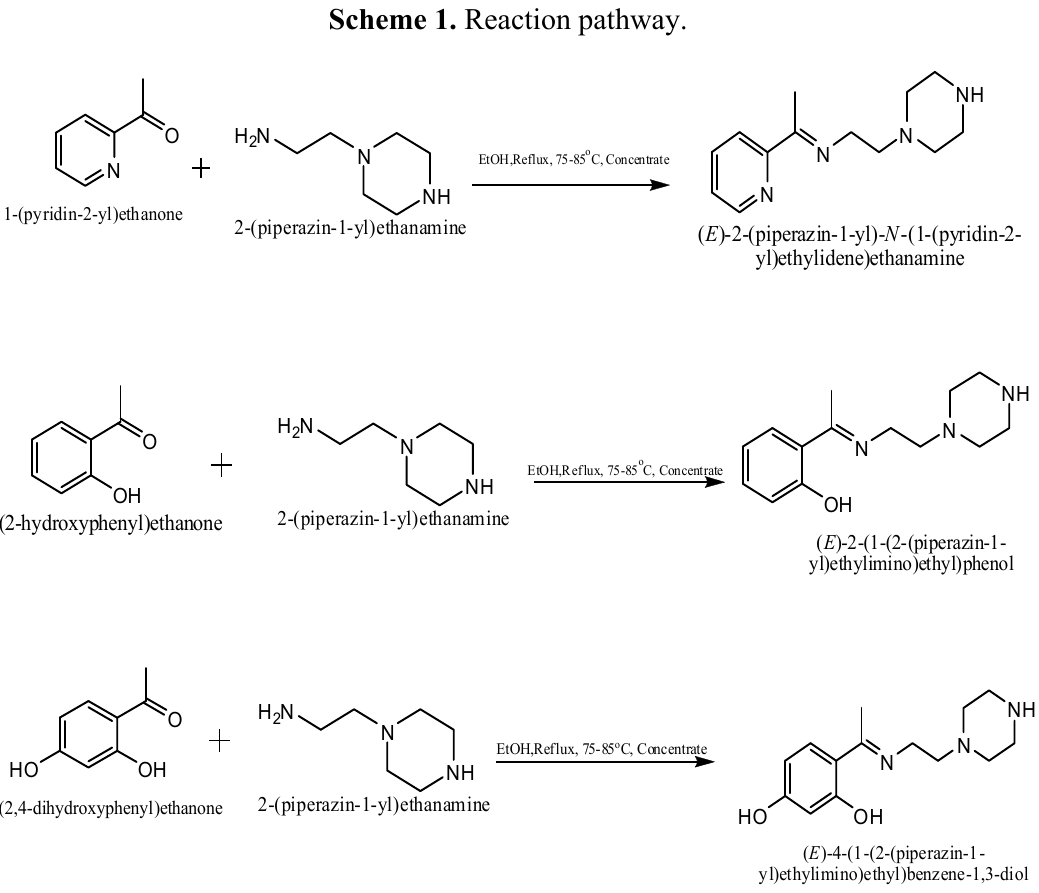
Scheme 1. Reaction